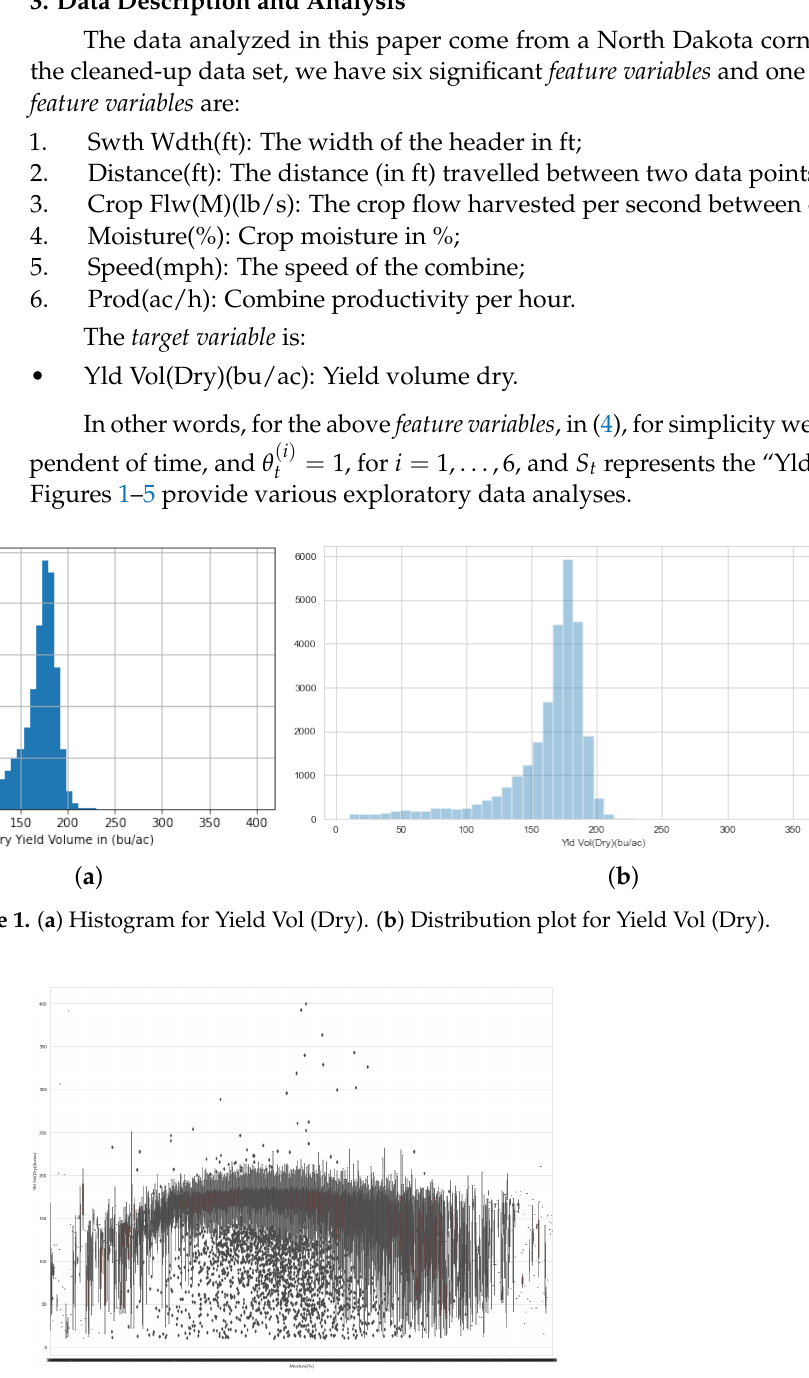
Figure 2. Box plot for Moisture (%) vs. Yld Vol